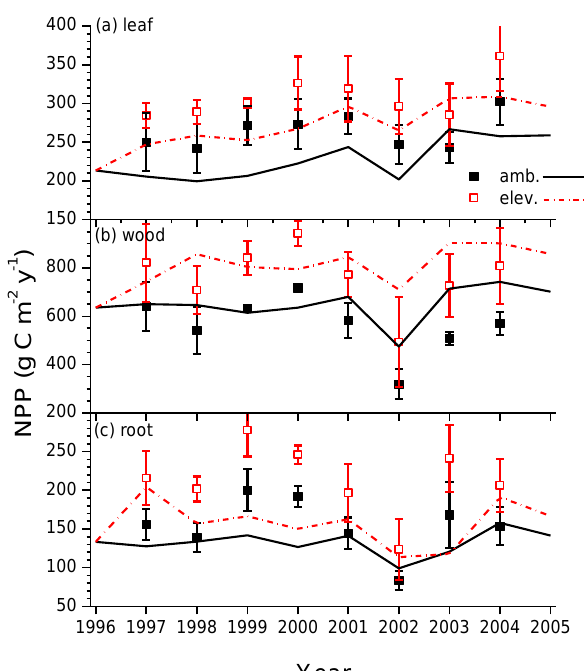
Fig. 3 Fig. 3. (a) Annual net primary productivity (NPP) measured (sym- bols) and modelled (lines) in (a) leaves, (b) wood and (c) roots from 1997 to 2004 under ambient ( ∼ 371µmolmol − 1 ) vs. elevated ( ∼ 571µmolmol − 1 ) C a at the Duke FACE experiment. Measured data from McCarthy et al. (2010), with error bars representing stan- dard errors from replicated measurements ( n = 4). Root exudation (Grant, 1993) was excluded from modelled NPP to simulate bio- metric